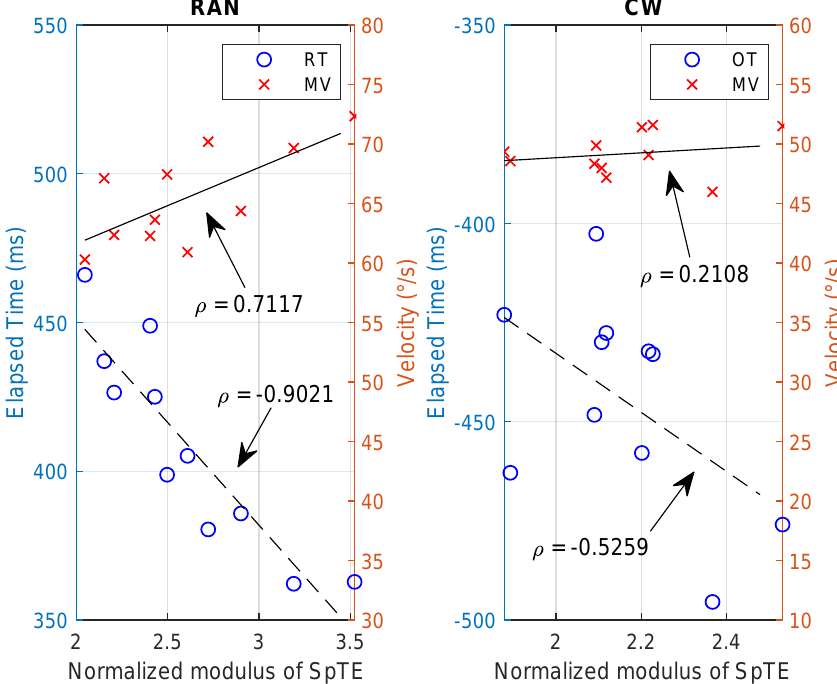
Figure 10. Correlation between reaction time, RT (or onset time, OT) and movement velocity (MV), with the normalised modulus of spatial error (SpTE), for both scenarios, RAN (graph on the left) and CW (graph on the